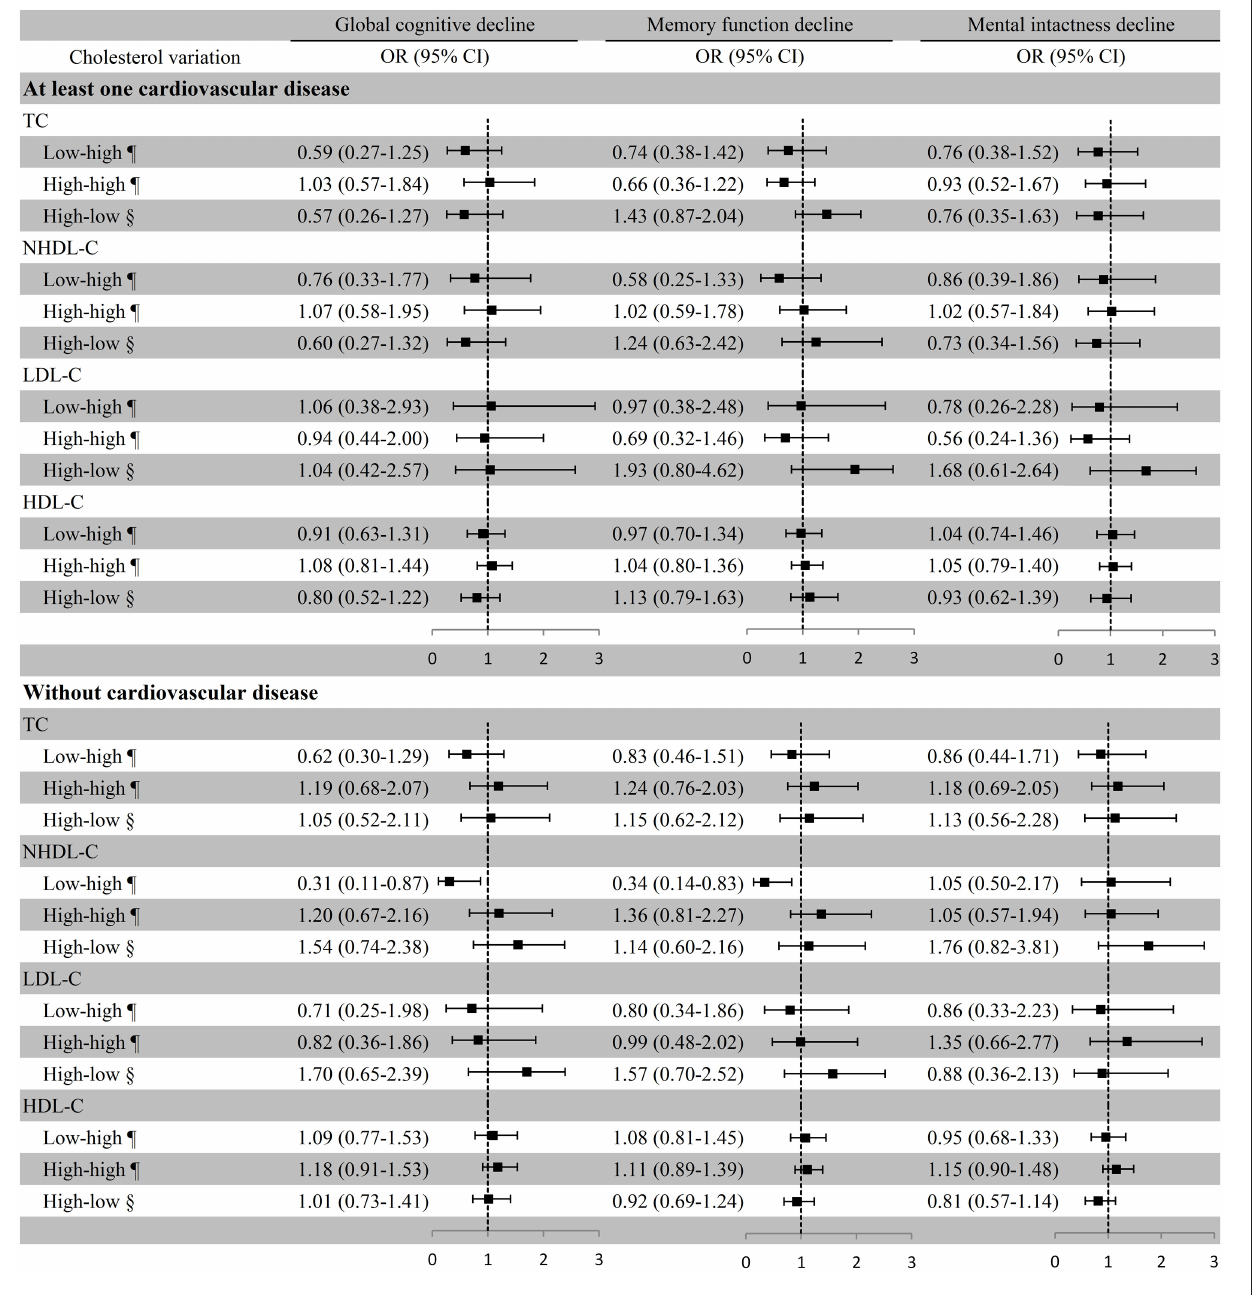
FIGURE 5 | Association between cholesterol variation and cognitive decline in participants with or without cardiovascular disease. ¶ Take the low–low group as a reference; § Take the high–high group as a reference. Baseline age, education, marital status, smoking, drinking, BMI, exercise, diabetes, history of disability, medication use (antihypertensive or antidiabetic medications), and the number of comorbidities were adjusted. TC, total cholesterol; NHDL-C, non-high-density lipoprotein cholesterol; LDL-C, low-density lipoprotein cholesterol; HDL-C, high-density lipoprotein cholesterol; OR, odds ratio; CI, confidence